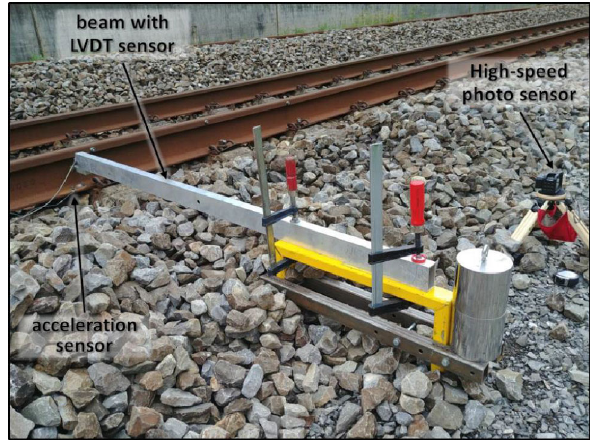
Fig. 2 Experimental setup for rail deflection and acceleration